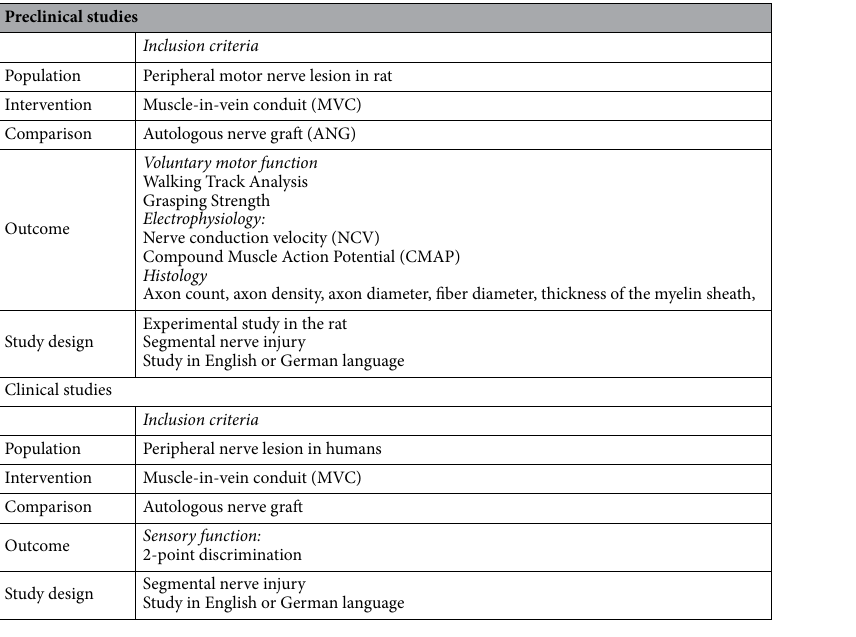
Table 1. Inclusion criteria for the systematic review and